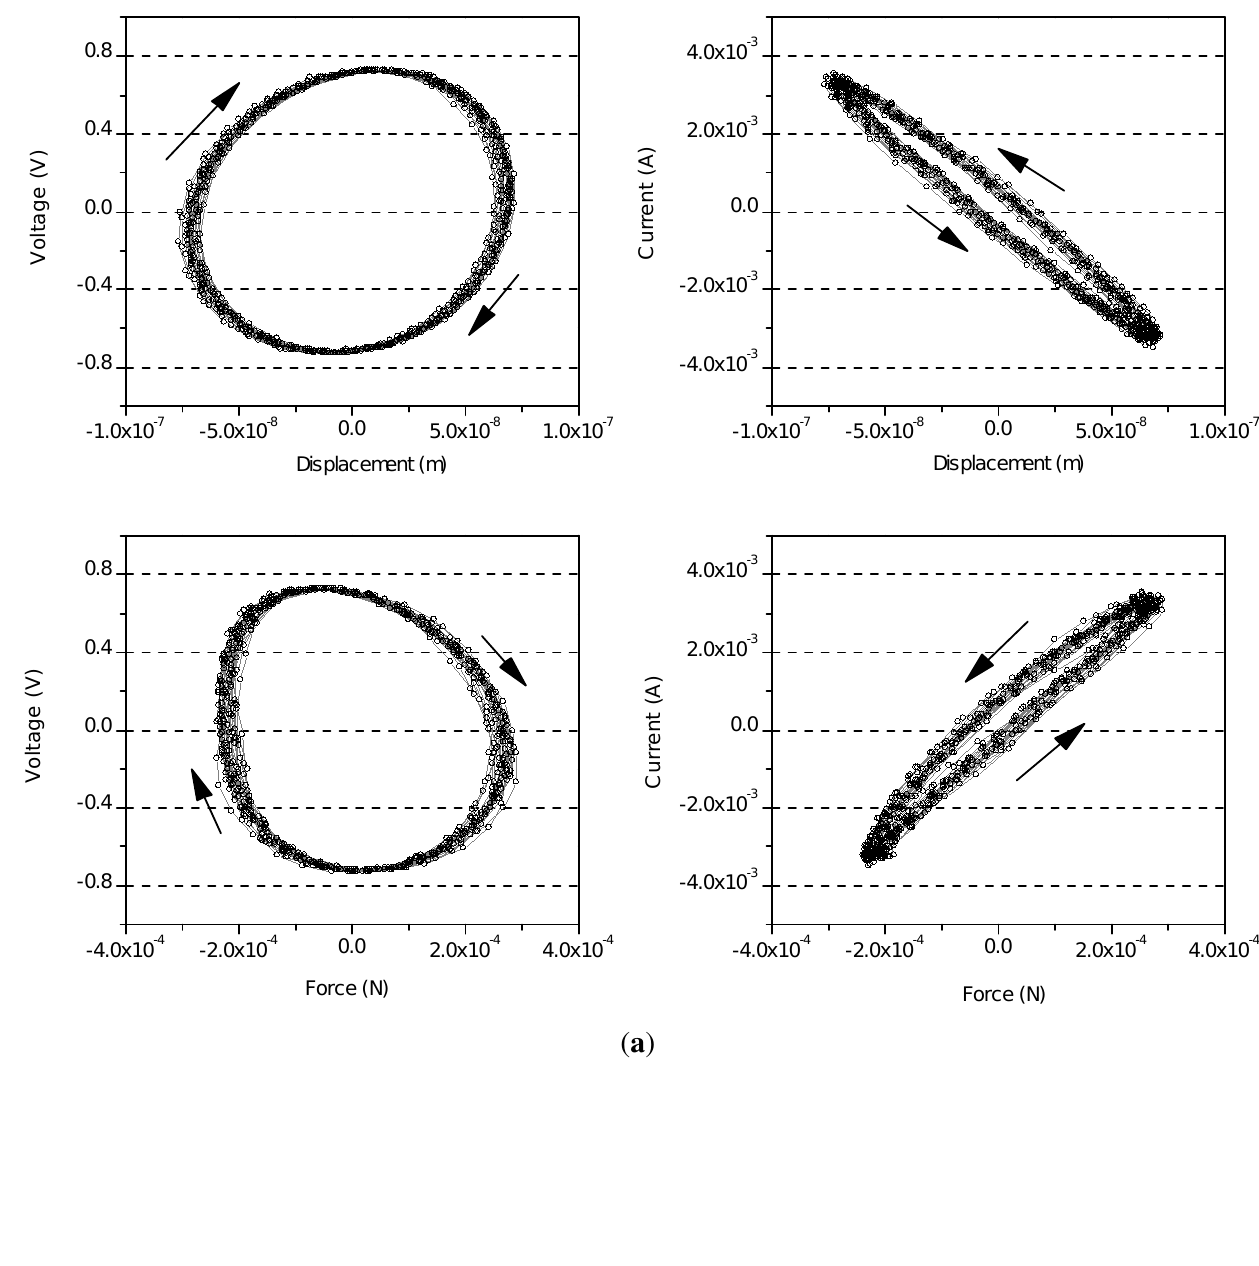
Figure 5. Voltage and current applied on the actuator, against displacement and force; ( a ) P1; ( b ) P2 and ( c )